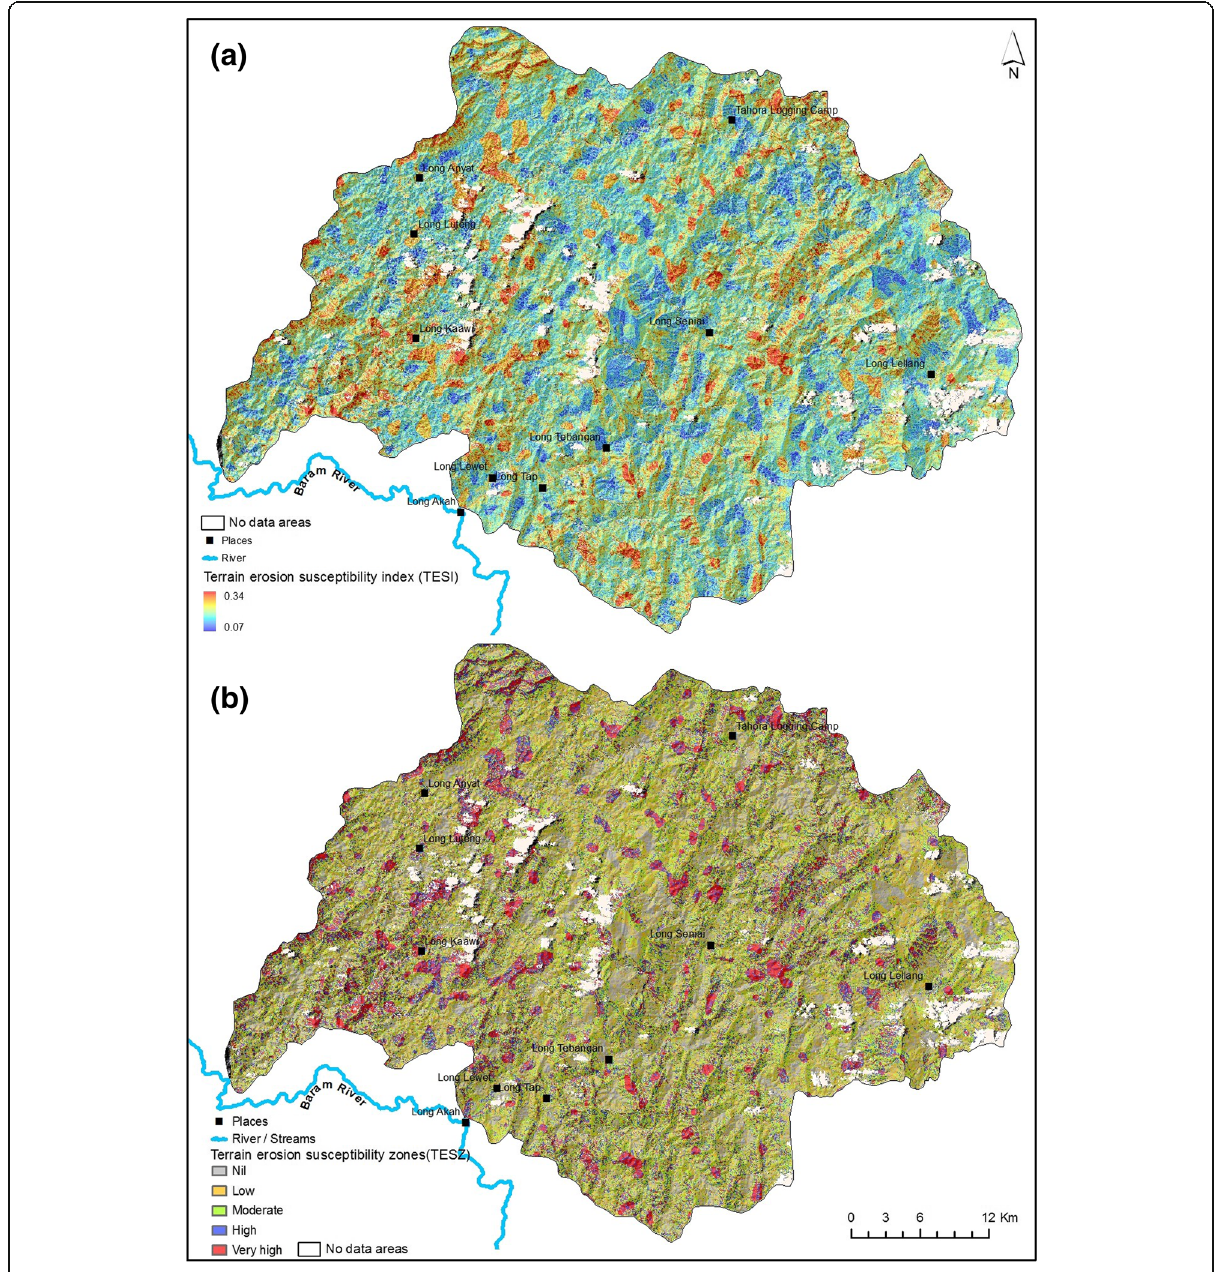
Fig. 4 a Terrain erosion susceptibility index (TESI) maps and b Classified terrain erosion susceptibility zonation (TESZ)